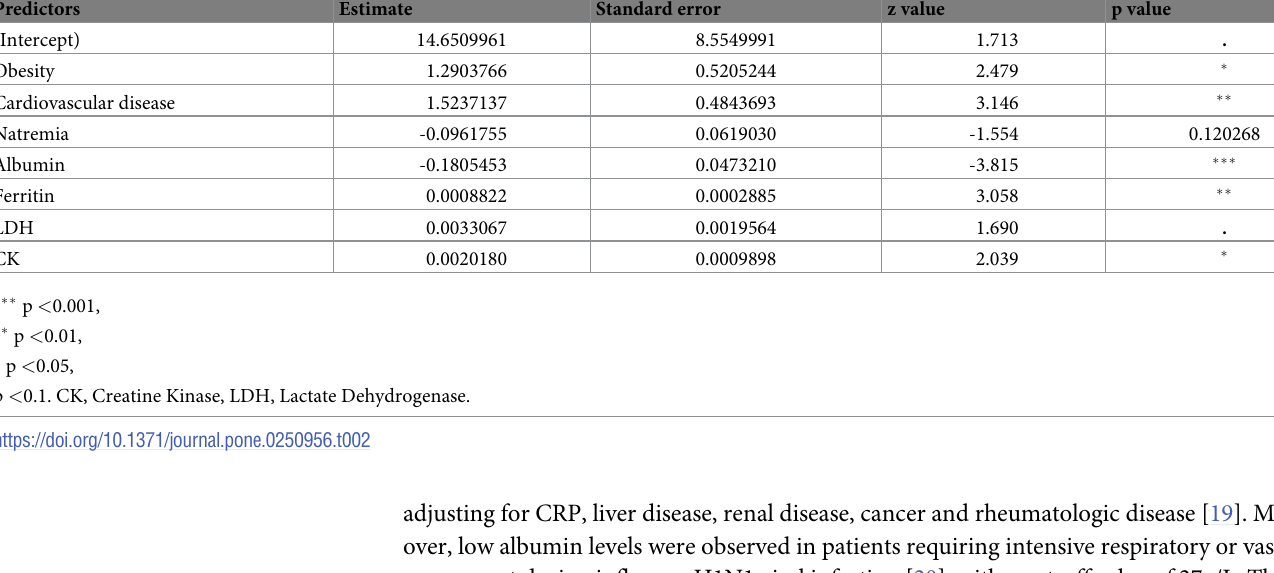
Table 2. Results of the stepwise model selection by Akaike Information Criterion (AIC) for model prediction of COVID-19 severity. Predictors